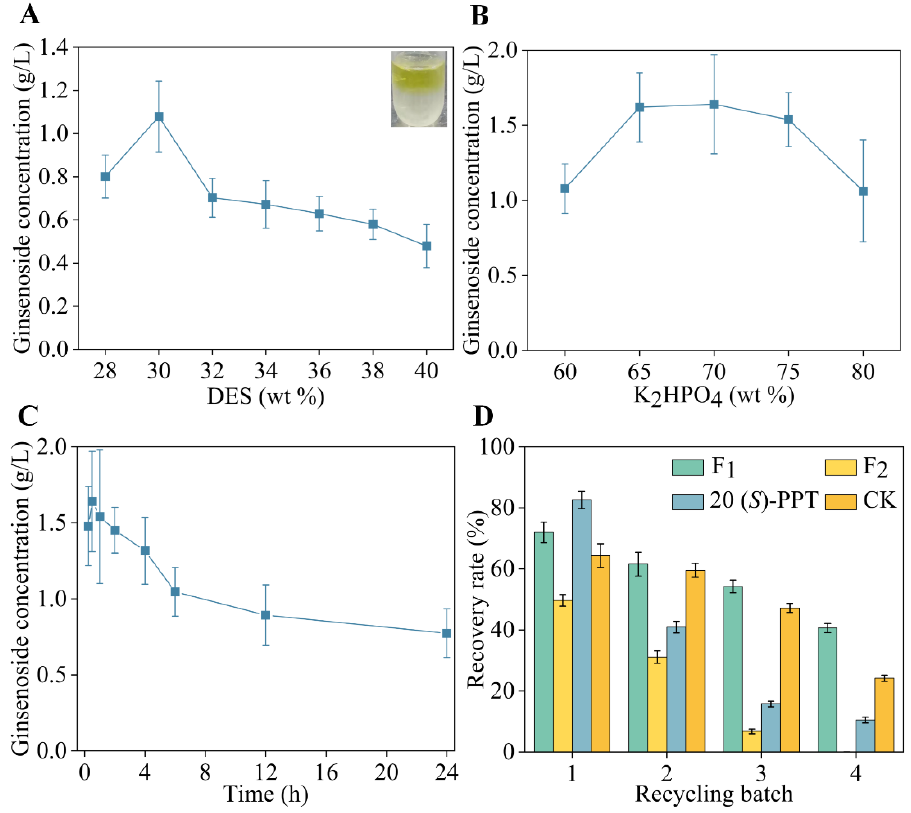
Figure 4. Optimization of ginsenosides extraction process by DES-based ATPS system. ( A ) Effects of the concentration (28, 30, 32, 34, 36, 38, and 40 wt %) of DES on the ATPS extraction process. ( B ) Effects of the concentration (60, 65, 70, 75, and 80 wt %) of K 2 HPO 4 on the ATPS extraction process. ( C ) Effects of the extraction time (0.25, 0.5, 1, 2, 4, 6, 12, and 24 h) on the ATPS extraction process. ( D ) Recovery testing of De-g (F 1 , F 2 , 20 ( S )-PPT, and CK) in multiple recycling batches.